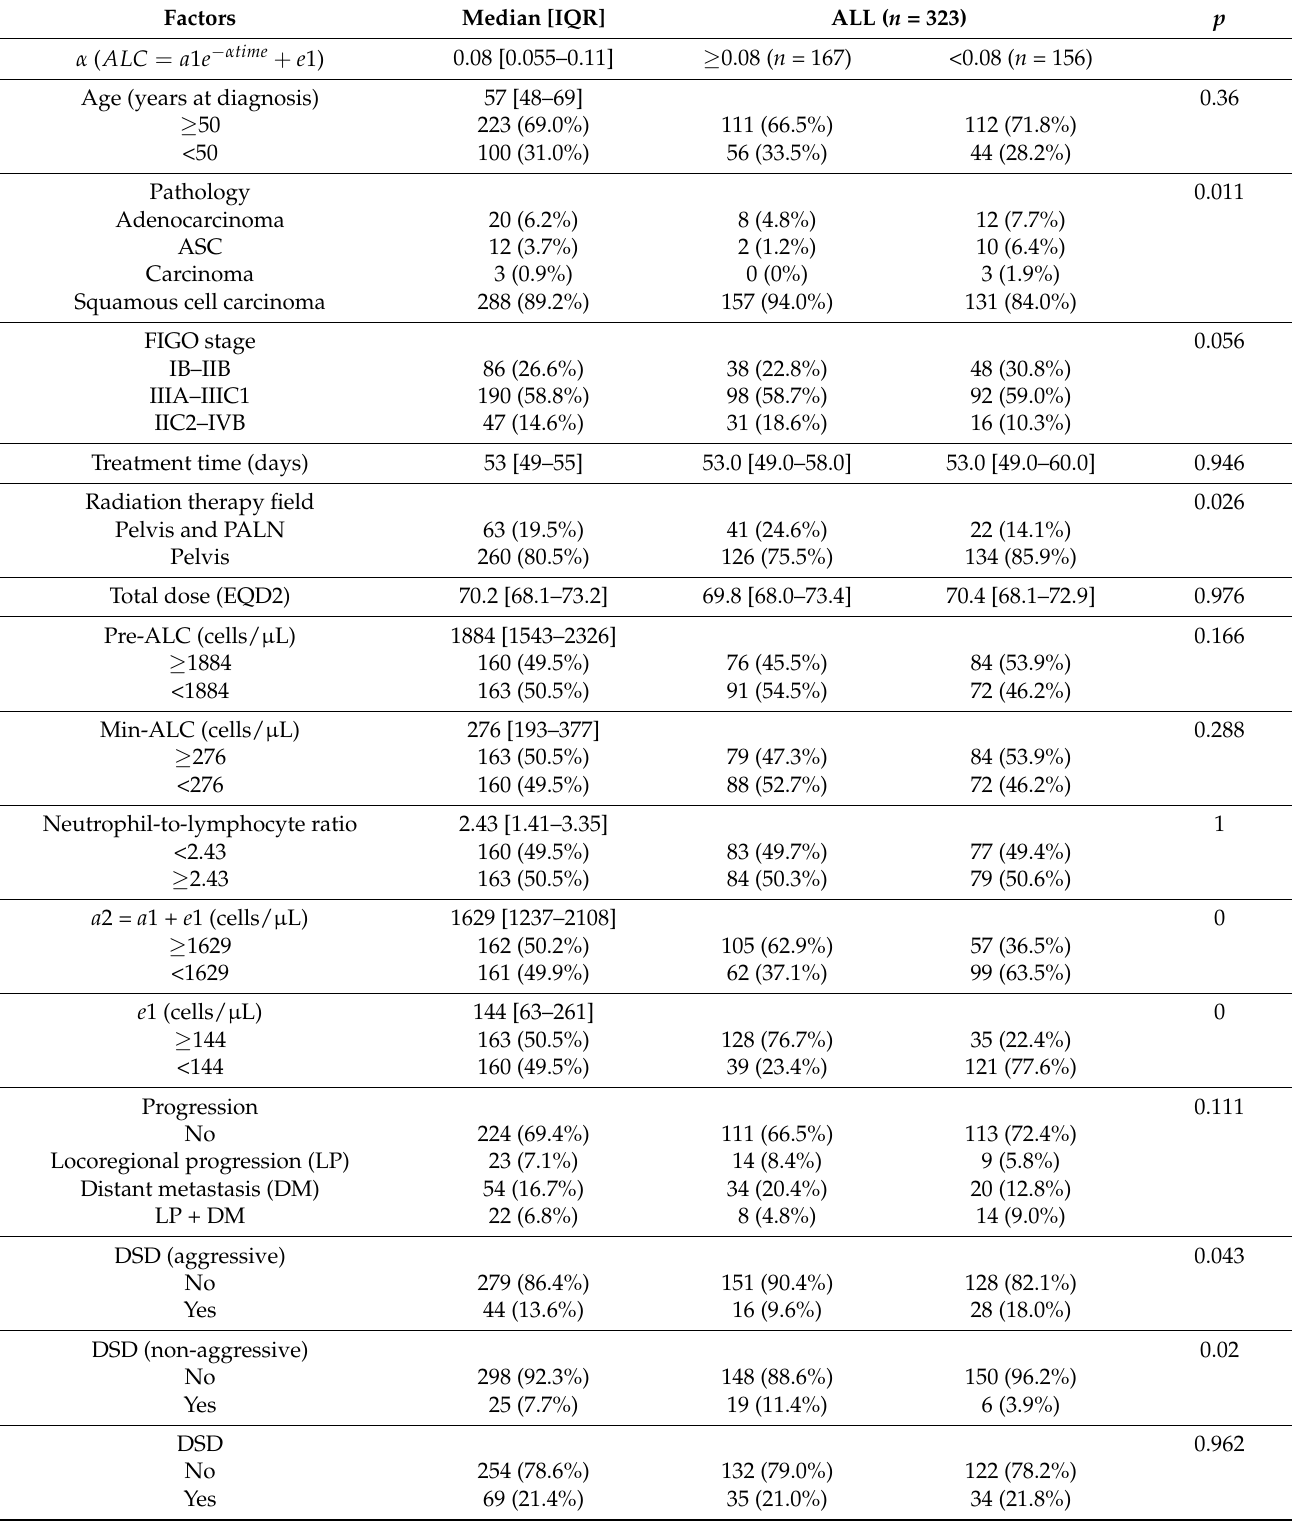
Table 1. Patients’ characteristics according to the median value of alpha (cohort